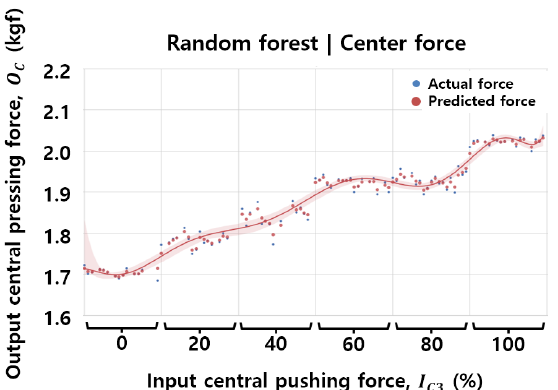
Figure 11. Random forest regression analysis result of output ( O C ) value according to input ( I C 3 )